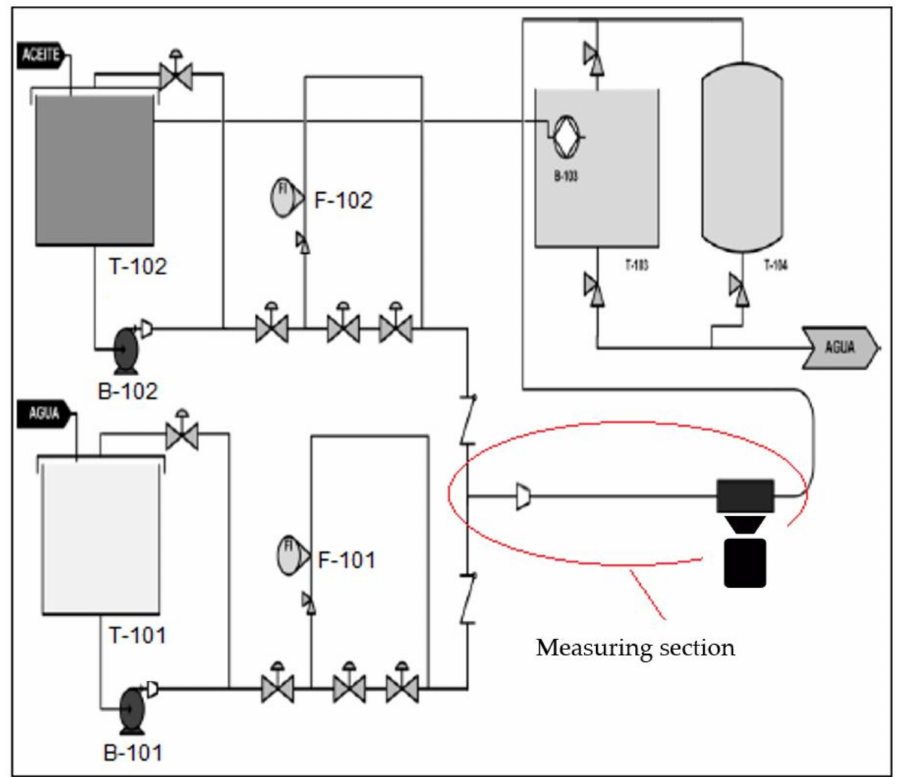
Figure 3. Setup of experiment